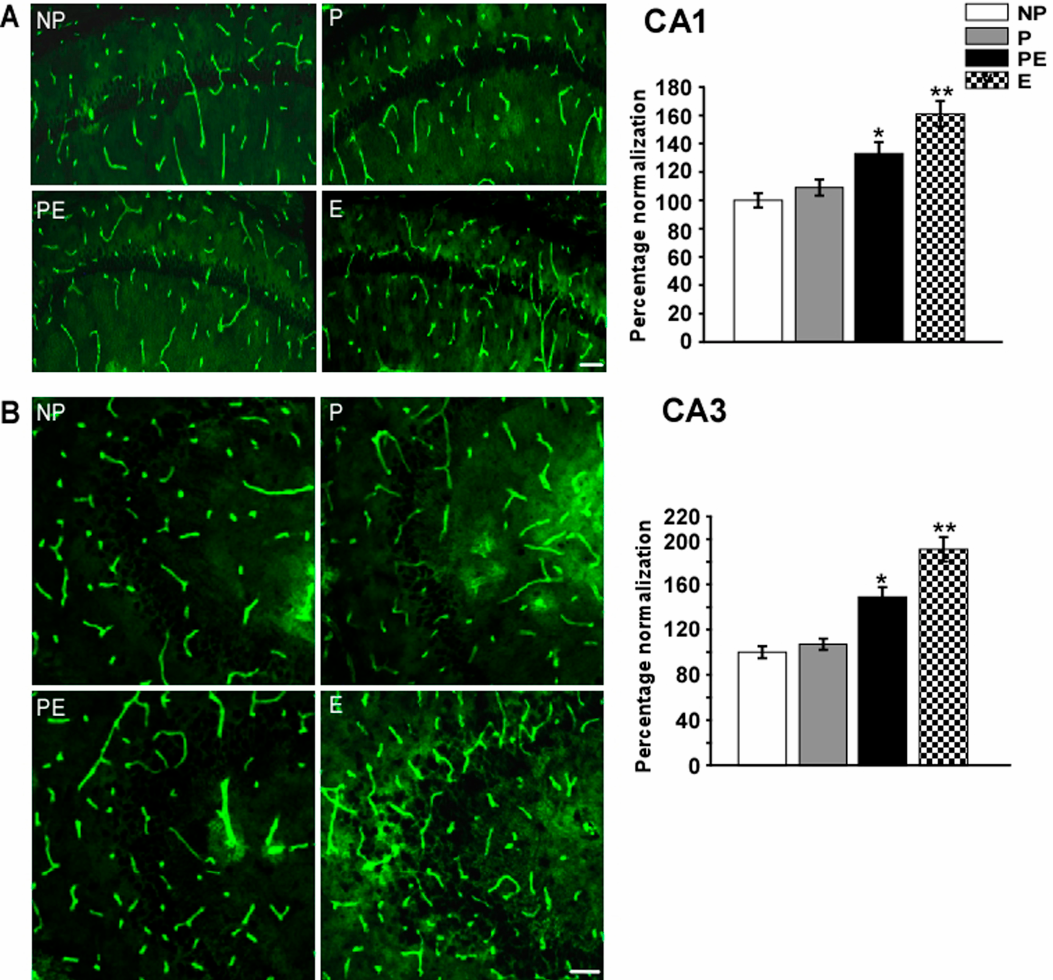
Figure 5. Changes in AQP4 immunoreactivity in the CA1 and CA3 areas after eclampsia were detected by immunofluorescent labeling ( n = 6). Immunofluorescent micrographs showing changes in fluorescence intensity of AQP4 in the CA1 ( A ) and CA3 area ( B ). Histograms showed the fluorescence intensity analysis of AQP4 in the CA1 and CA3 areas in all groups. ( A ) * p < 0.05, PE group vs. NP and P groups. ** p < 0.05, PE group vs. E group; ( B ) * p < 0.01, PE group vs. NP and P groups. ** p < 0.05, PE group vs. E group. Scale bar = 50 µm.